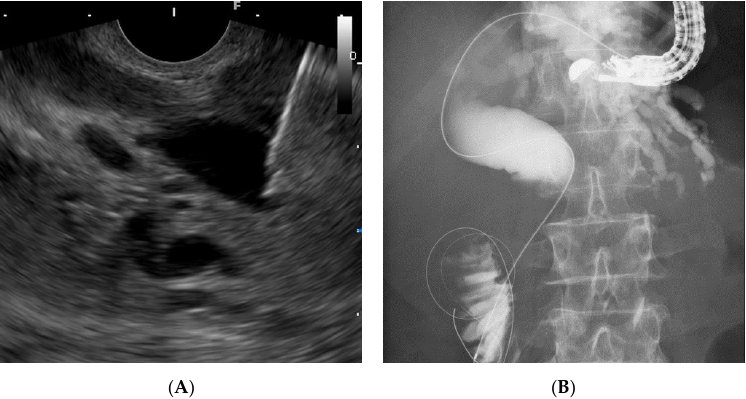
Figure 3. The left intrahepatic bile duct/stomach (LIHBD/S) route. Endoscopic ultrasound image ( A ) showing needle puncture of the left intrahepatic bile duct (B3) from the stomach. Fluoroscopic image ( B ) showing that the guidewire passed through the stricture and papilla into the duodenum.